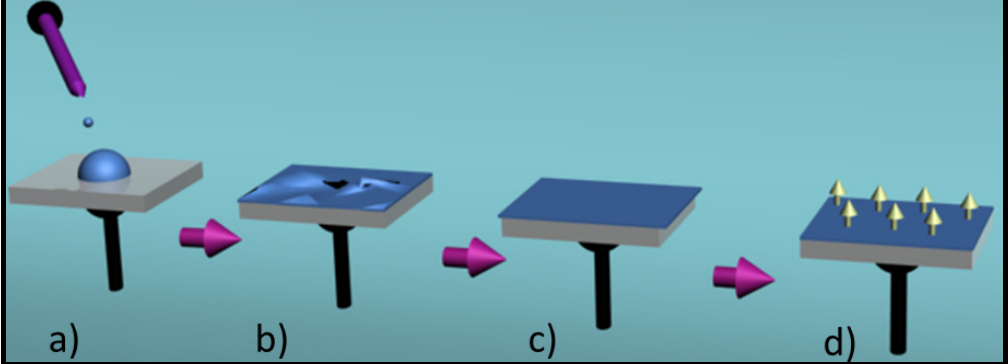
Figure 4. Spin coating process involves the following steps: ( a ) Solution deposition; ( b ) Substrate acceleration; ( c ) Constant spinning rate; and ( d ) Drying and separation (not shown).